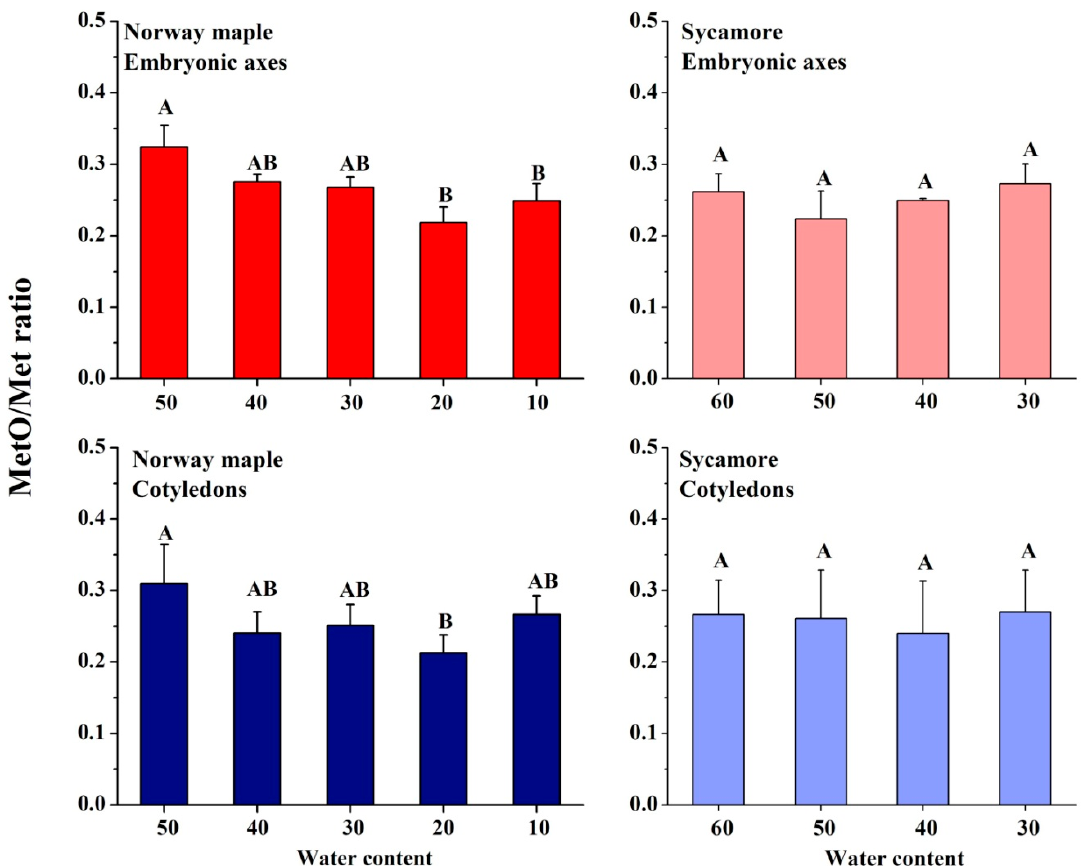
Figure 2. Proportion of Met oxidized to methionine sulfoxide (MetO) in proteins of desiccated Norway maple and dehydrated sycamore seeds. A representative chromatogram indicating peaks recognized at 214 nm is shown. Standards of Met, MetO, tyrosine (Tyr) and tryptophan (Trp) were used for the calibration curves. The MetO ratio was calculated in relation to the total pool of Met. The data are the means of three independent replicates ± the STDs. The same letters indicate groups that are not significantly different according to Tukey’s test.